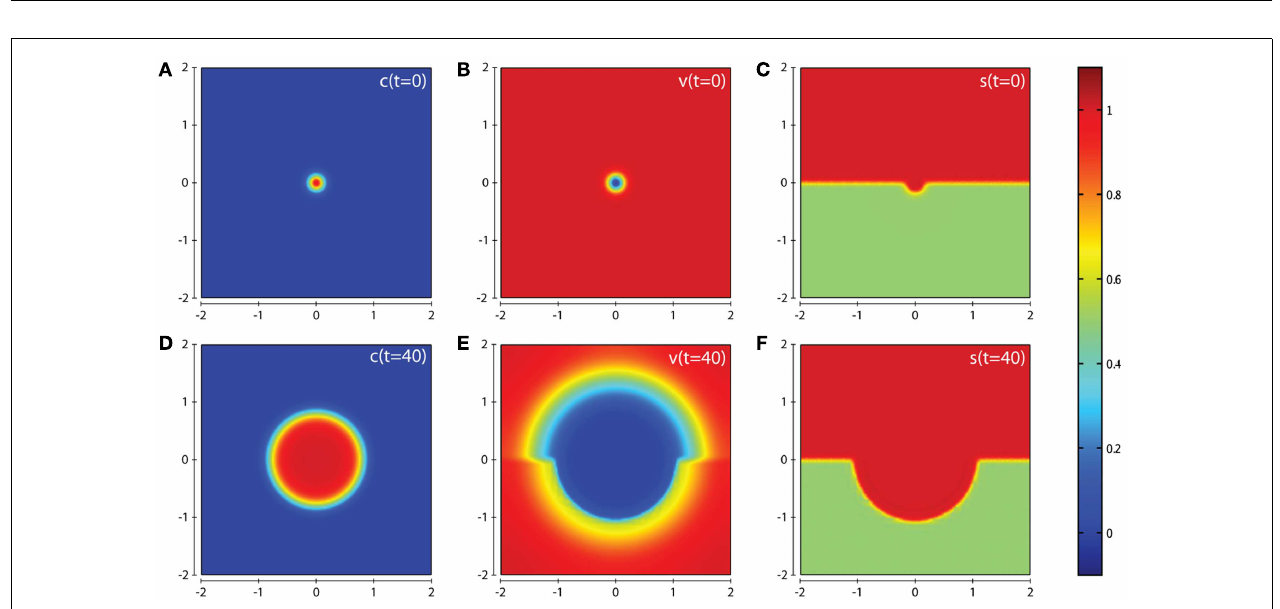
MMP-2 and MT1-MMP concentrations at t = 40 with appropriate thresholds near the invasive front of the cancer cell invasion.The white contour line shows the cancer cell density at level 0.01 chosen to represent the maximum extent of invasion. Simulations are performed using the baseline parameter set.